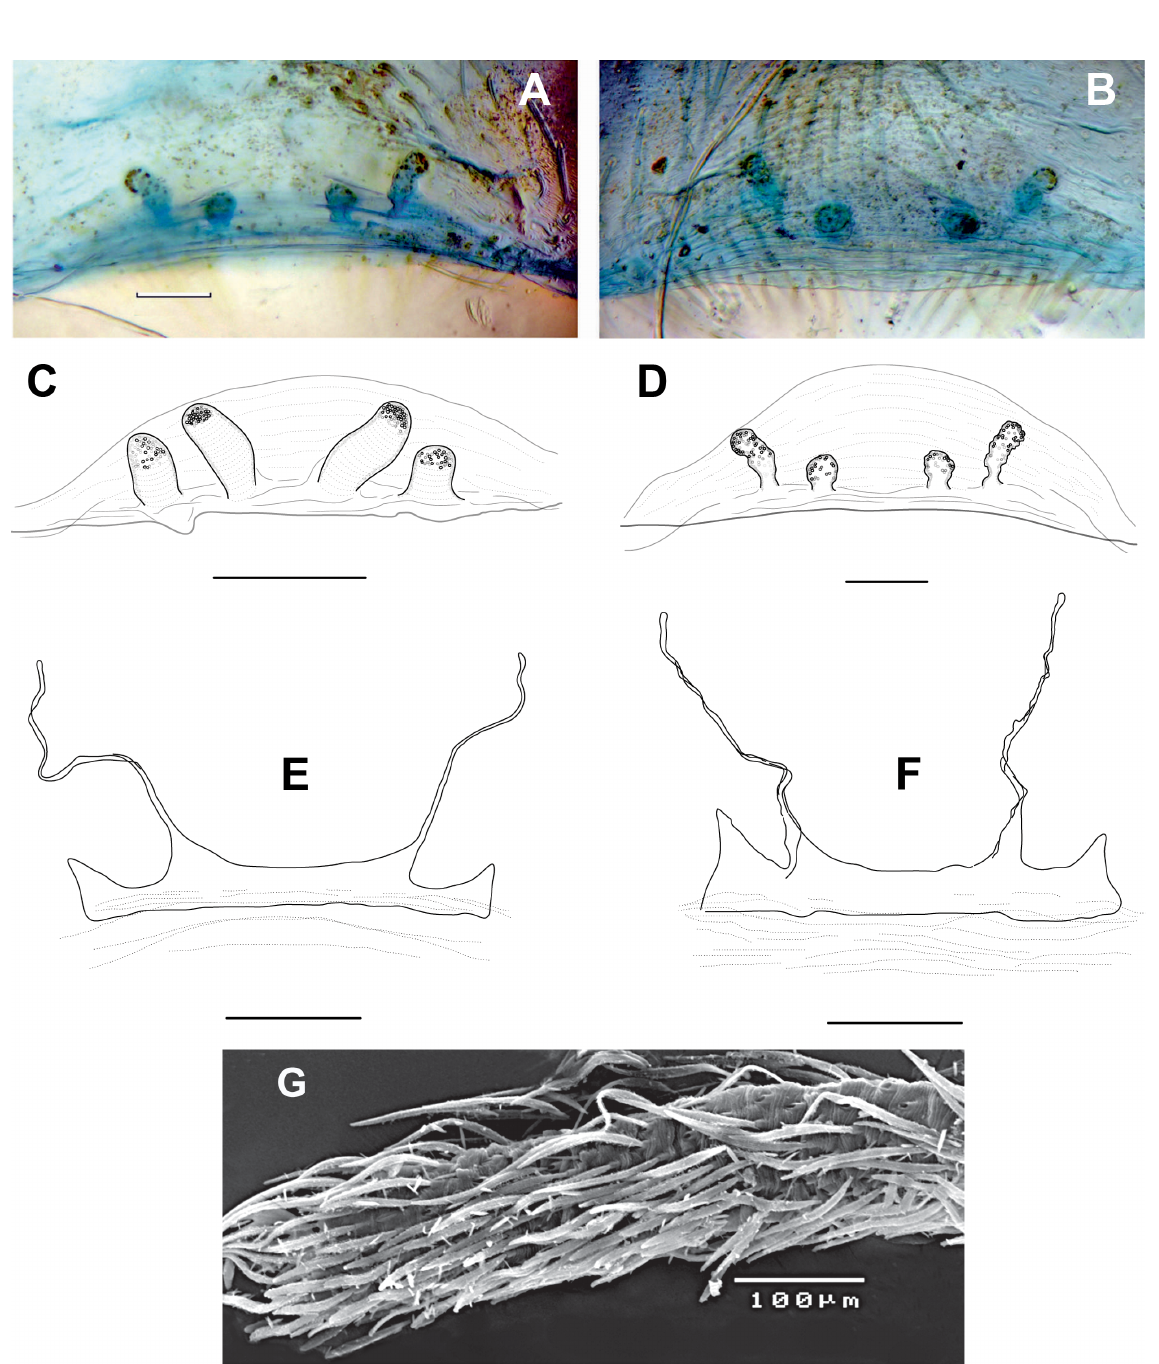
Fig. 33. Somatic characters and copulatory organs of Zaitunia wunderlichi sp. nov., paratype, ♀ ( A–B , D ), Z. beshkentica (Andreeva & Tyshchenko, 1969), ♀ from Babatagh Mts ( C ), Z. logunovi sp. nov., paratype, ♂ ( E , G) and Z. schmitzi (Kulczyński, 1911), ♀ from Jerusalem area ( F ). — A – D . endogyne, dorsal ( A , C – D ) and ventral ( B) . E–F . Posterior respiratory system, dorsal. G . Close-up view of male tarsus iV, prolateral, showing pseudosegmentation. Scale bars: a–B, D–G = 0.1 mm; C = 0.2